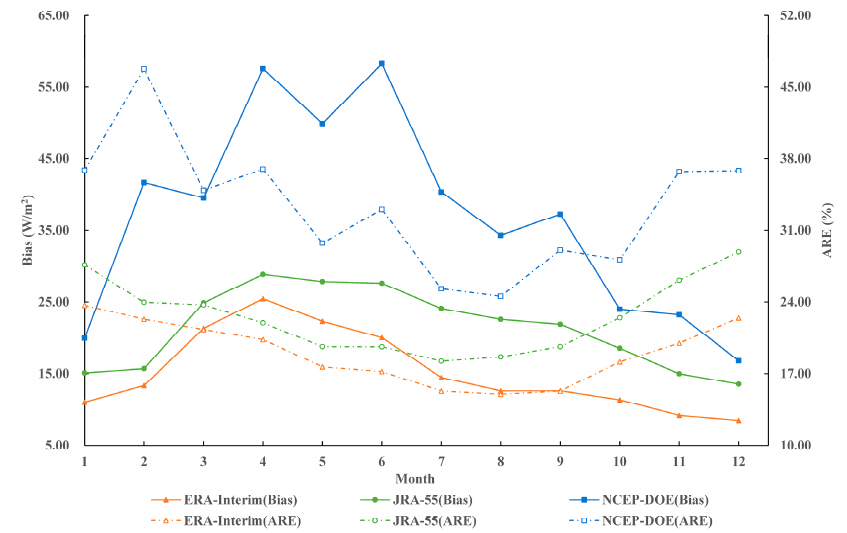
Figure 3. Monthly variation of bias and ARE of the three solar radiation reanalysis products.